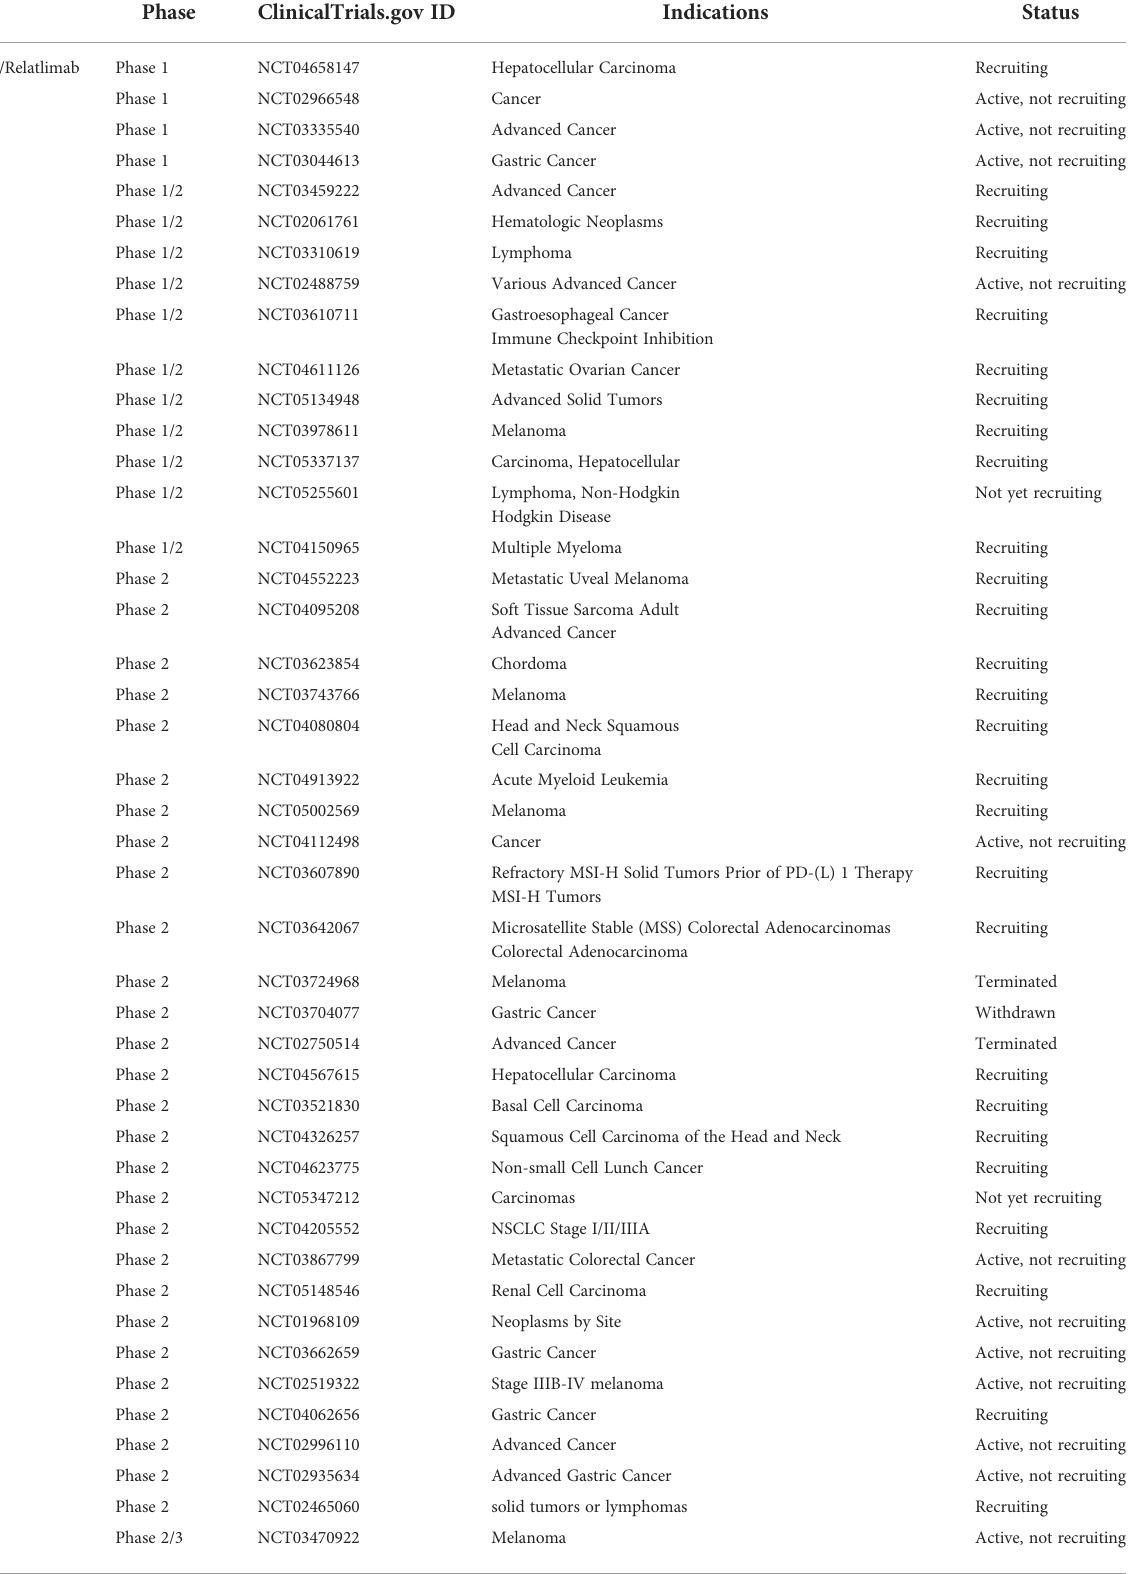
TABLE 1 LAG3-modulating candidates a .